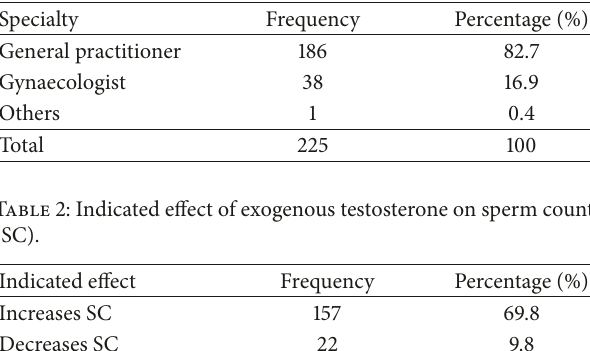
Table 1: Specialty of respondents.